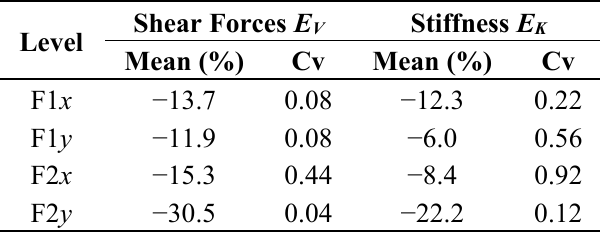
Table 5. Average (Mean) and coefficient of variation (Cv) of percentage errors (linear